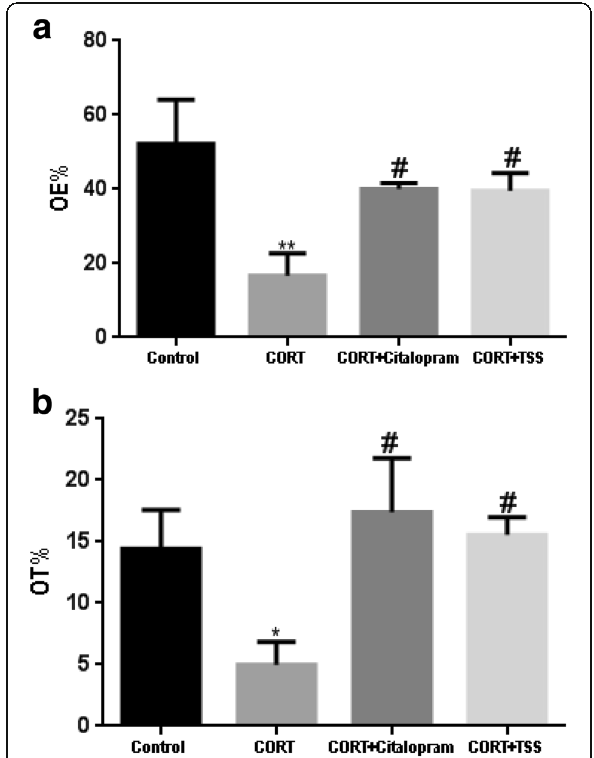
Fig. 4 Effects of TSS (25 mg/kg) and citalopram (10 mg/kg) on the EPM test in the chronic CORT treatment mice. a the percentage of open arm entries (OE%). b the percentage of time on the open arms (OT%). Data